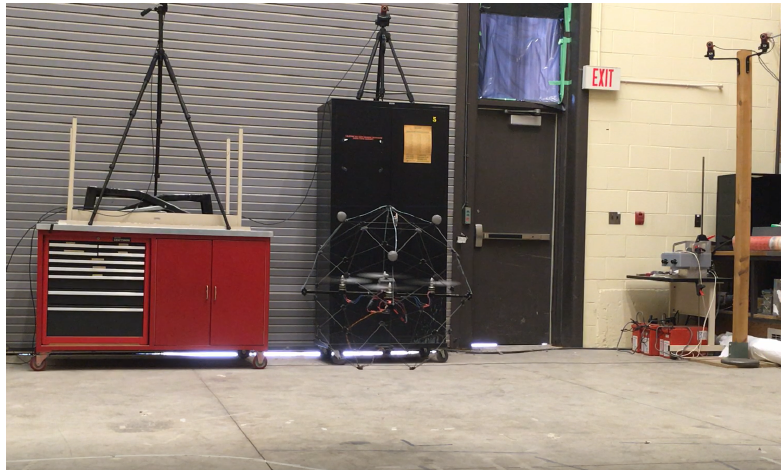
Figure 6. The Qball-X4 quadrotor during the experiment.